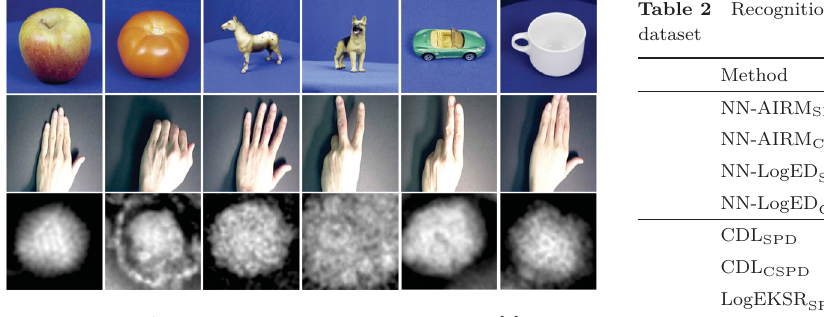
Fig. 3 Images from the three datasets. Top: ETH-80 [4]. Middle: CG [5]. Bottom: virus [13].